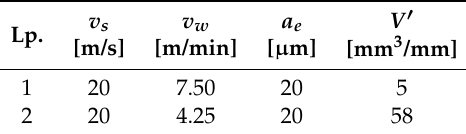
Table 5. The adjustable process parameters with which the grinding wheels worked, excluded from the regression analysis, and the specific volume of the material they